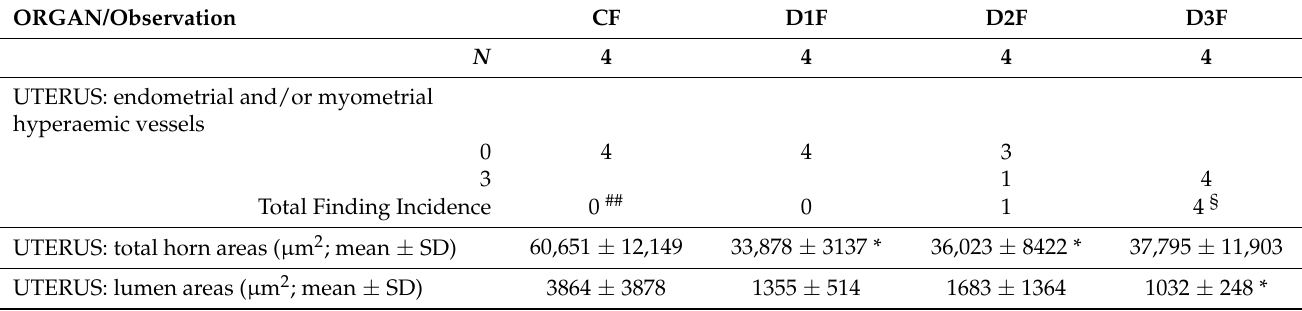
different doses of testosterone enanthate two times a week, for 2 weeks: CF 0—sesame oil, D1F